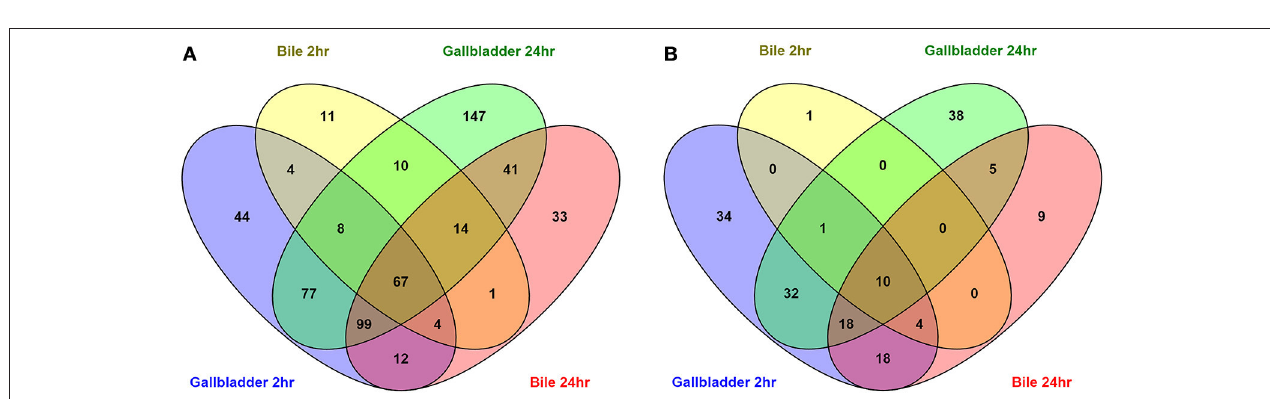
FIGURE 3 | Venn diagrams depicting the overlap of upregulated (A) and downregulated (B) annotated genes in all conditions compared to the unexposed IA3902 inoculum. Differential expression of all known annotated genes were compared to each other utilizing the Venny program.